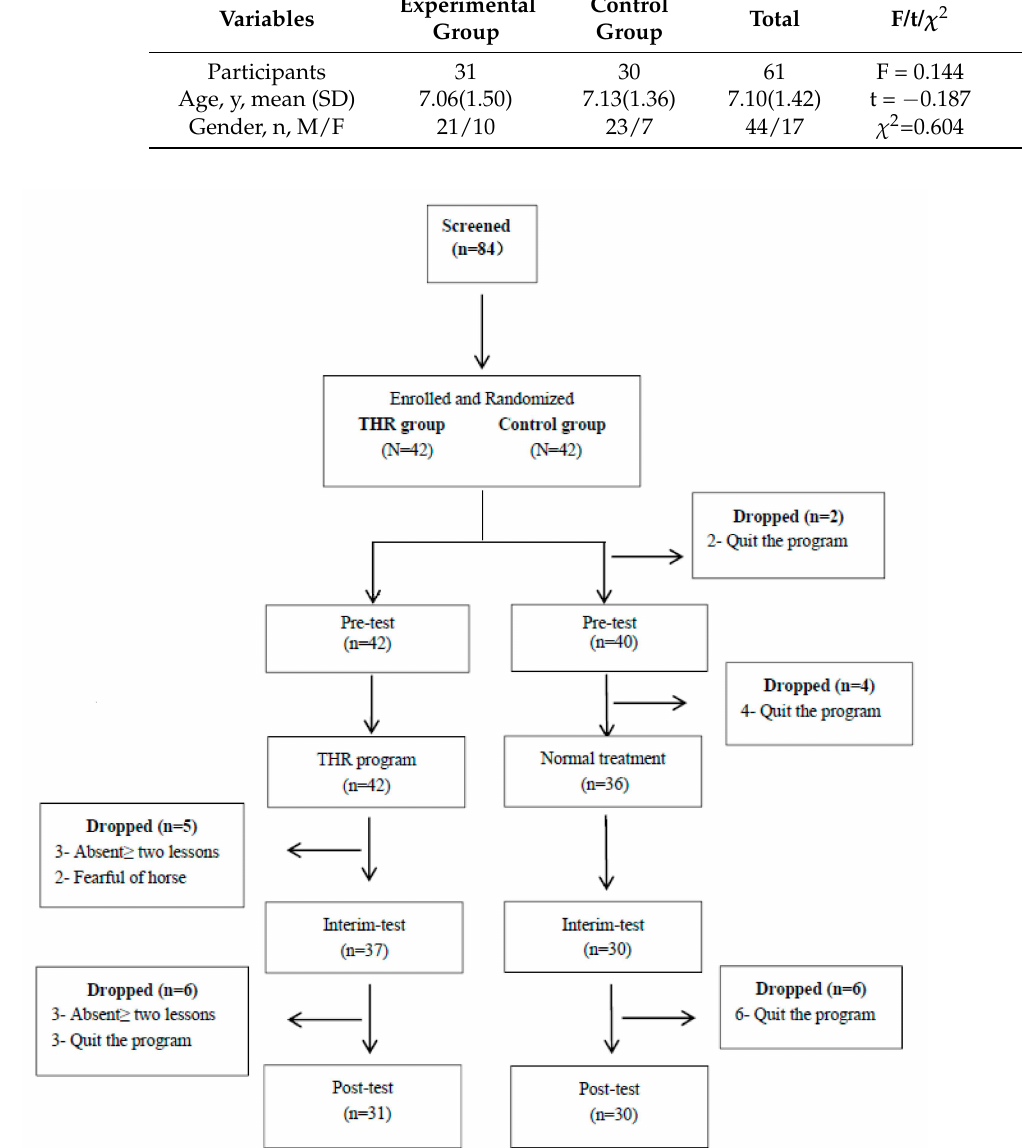
Figure 1. Participant flow